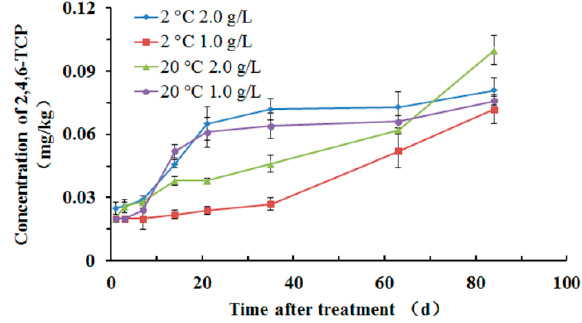
Figure 2. Residual behavior of 2,4,6-TCP in apple whole fruit.